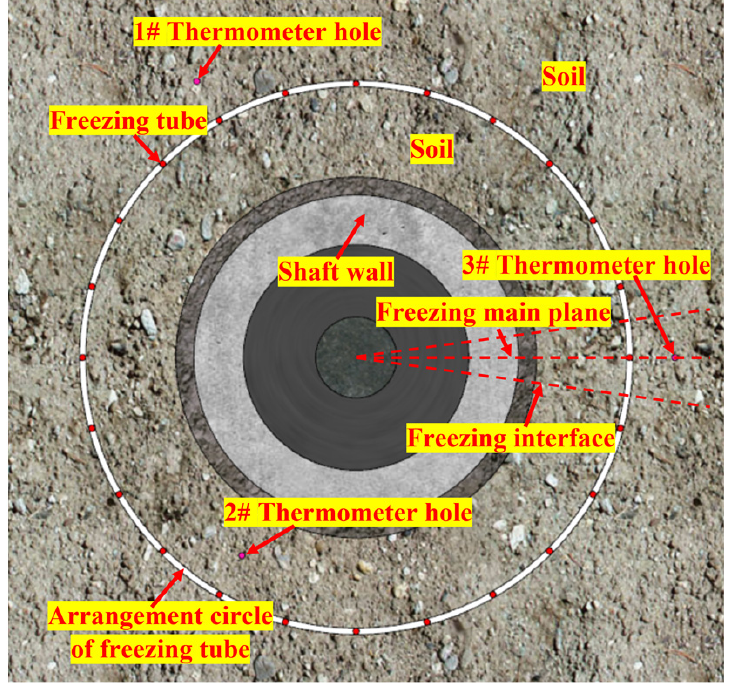
Figure 1. Schematic diagram of shaft construction by the artificial ground freezing method.